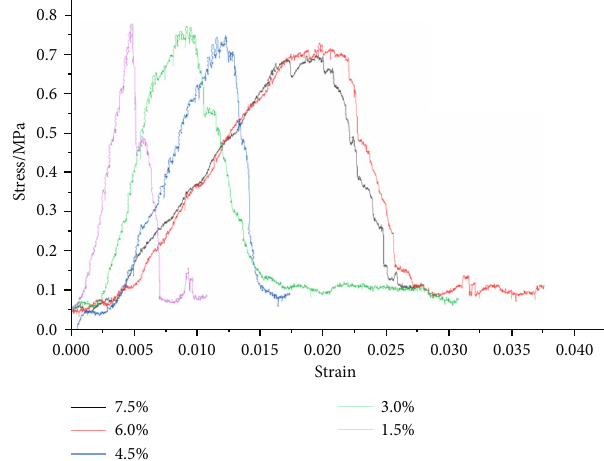
Figure 7: Total stress-strain process curves of coal samples with di ff erent moisture